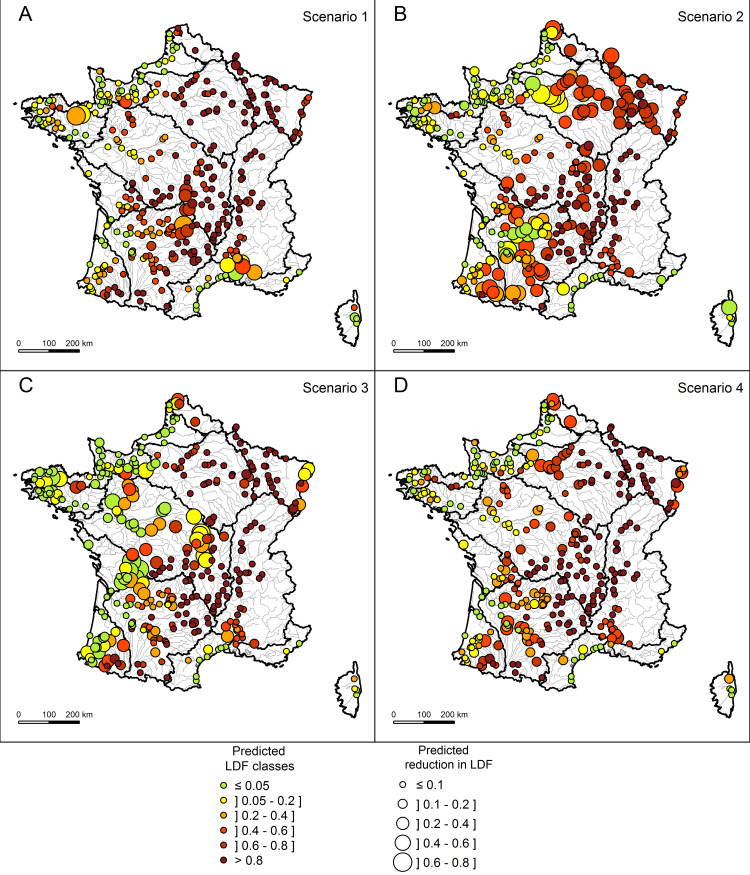
Reduction in predicted LDF induced by each scenario.The colors correspond to the LDF classes calculated (A) after removing barriers over 10 m in height (Scenario 1), (B) after removing barriers between 2 m and 10 m in height (Scenario 2), (C) after removing barriers under 2 m in height (Scenario 3) and (D) after reducing local hydrological, morphological and water quality alterations (Scenario 4). The circle size represents the predicted reduction in LDF compared to the initial conditions without any scenario.